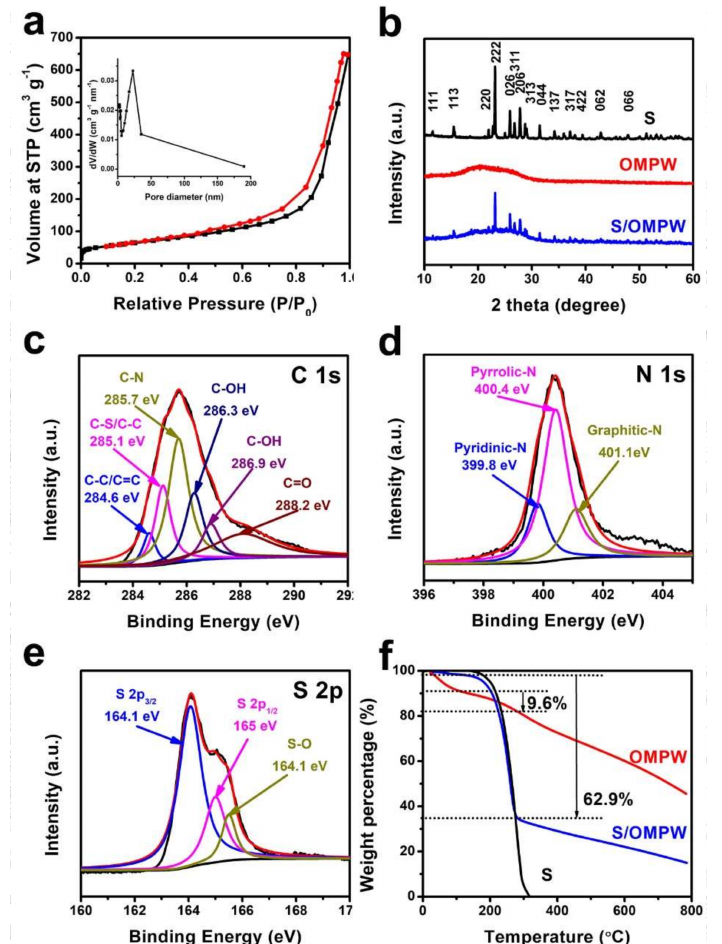
Figure 4. ( a ) Nitrogen adsorption-desorption isotherms and pore size distribution (PSD) curves (insert) of OMPW, ( b ) XRD profiles of S, OMPW, and S/OMPW composite, ( c – e ) X-ray photoelectron spectroscopy (XPS) spectra of S/OMPW composite, ( f ) TGA curves of S, OMPW, and S/OMPW